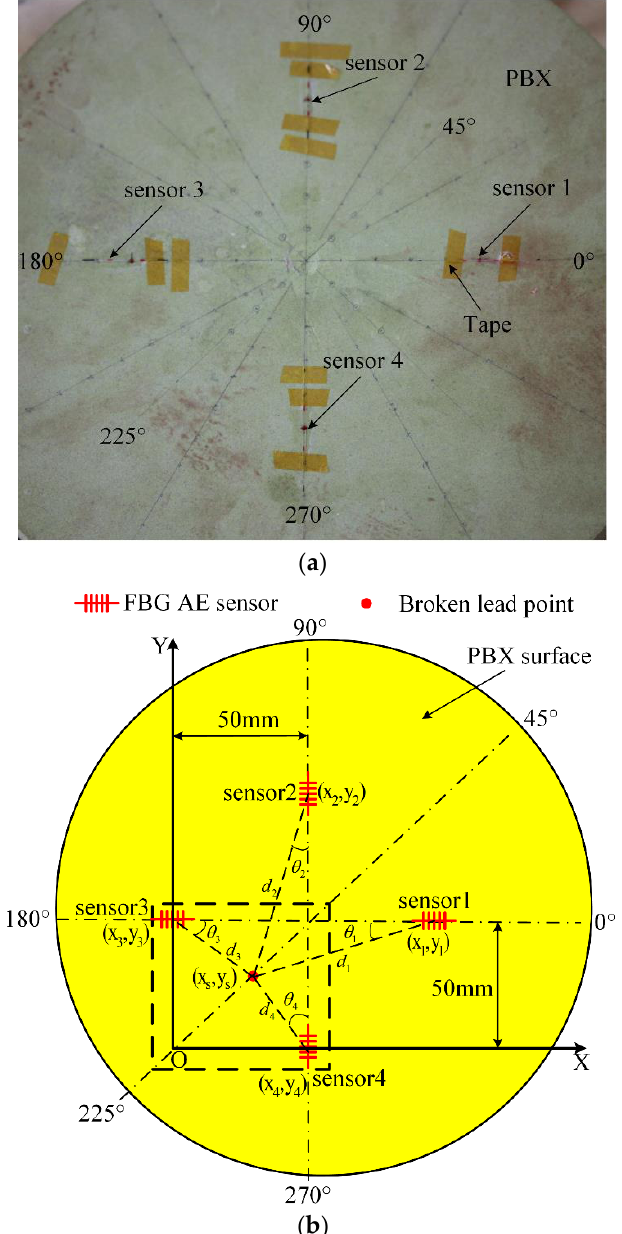
Figure 10. FBG AE source location experiment on a thin PBX sample. ( a ) Photograph of four sensors on the PBX surface; ( b ) source location experiment of a broken lead point.